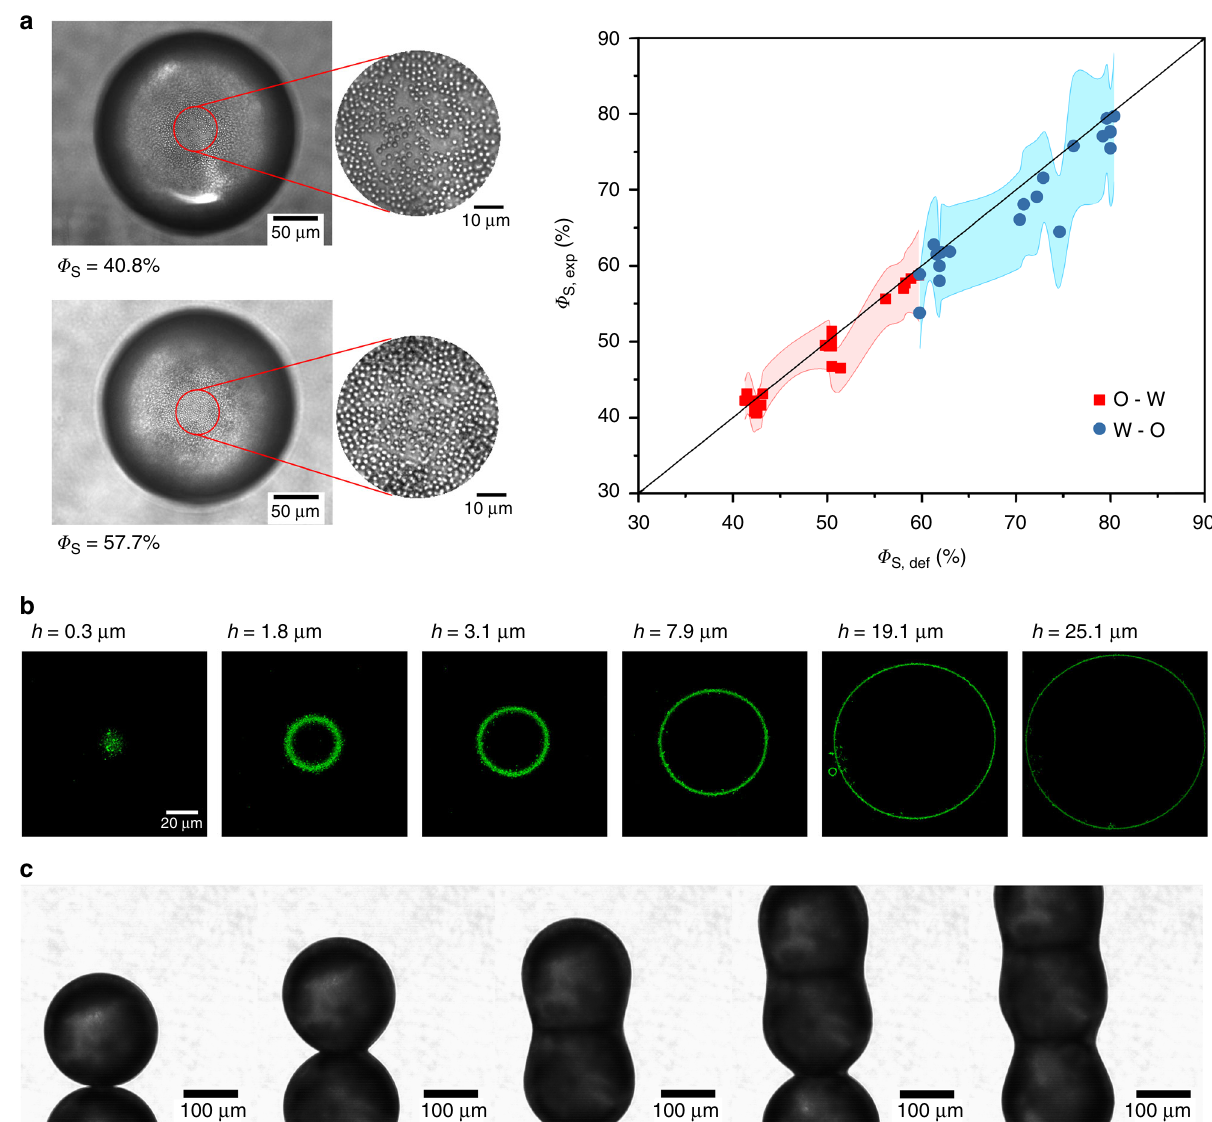
Fig. 3 Control over surface coverage. a Micrographs of typical silica particle stabilized droplets at Φ s = 40.8% and Φ s = 57.7% and the comparison between the desired ( Φ s,def ) versus the experimentally obtained Φ s,exp surface coverage for oil-water and water-oil systems, with the shaded areas a conservative error obtained from the image analysis as explained in the text. b Confocal image of a single droplet showing particles only on the interface. c Arrested coalescence of droplets with an initial surface coverage Φ s = 85.5% which due to surface jamming halt shape